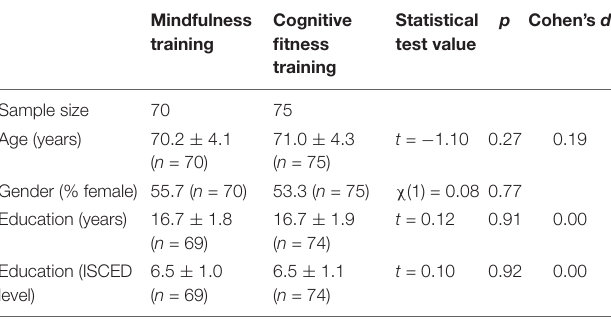
TABLE 1 | Baseline characteristics of study